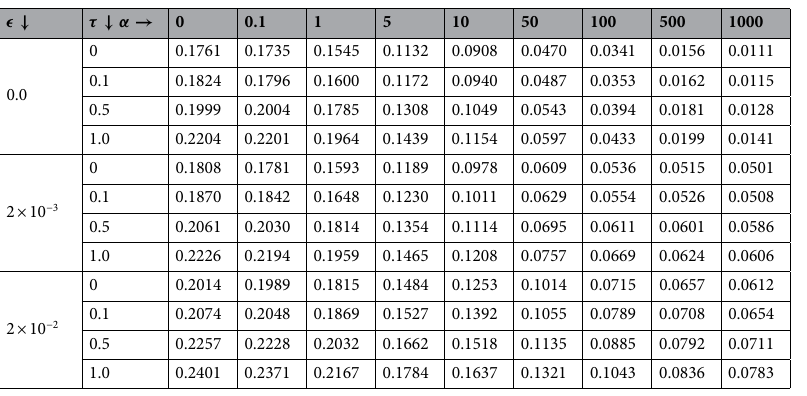
Table 4. Floating ion density I f (α , τ , ǫ)